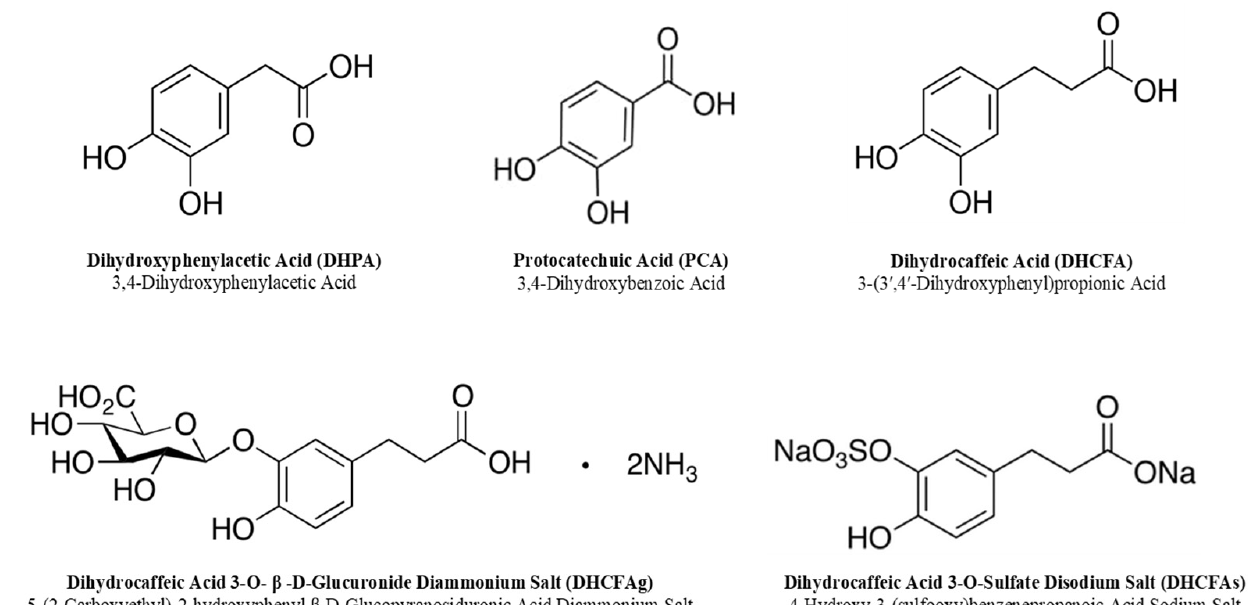
Figure 2. Chemical structures of the phenolic metabolites tested in this study.